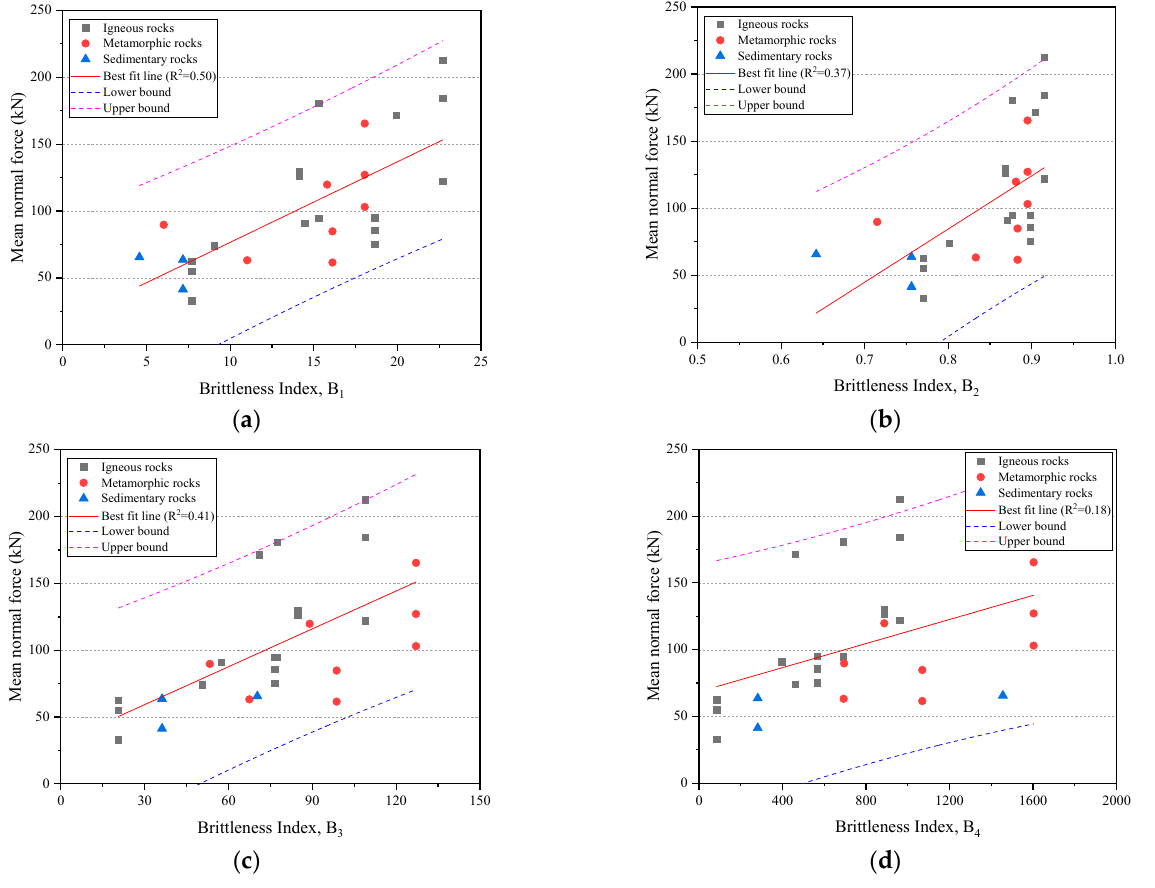
Figure 7. Relationship between brittleness indices and mean normal force: ( a ) MNF–B 1 ; ( b ) MNF–B 2 ; ( c ) MNF–B 3 ; ( d ) MNF–B 4 .